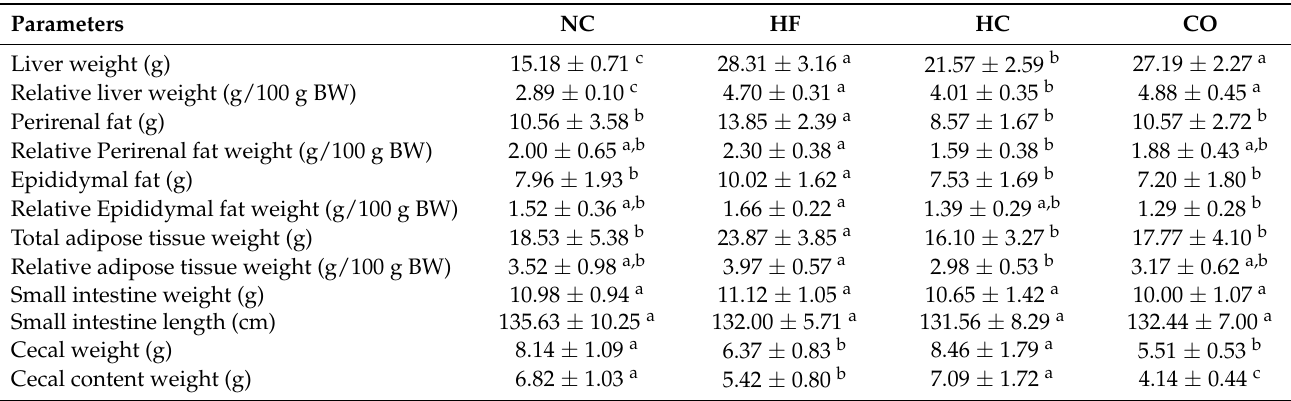
Table 2. The changes in body weight, food intake, and food utilization rate in rats fed with different experimental diets for 12